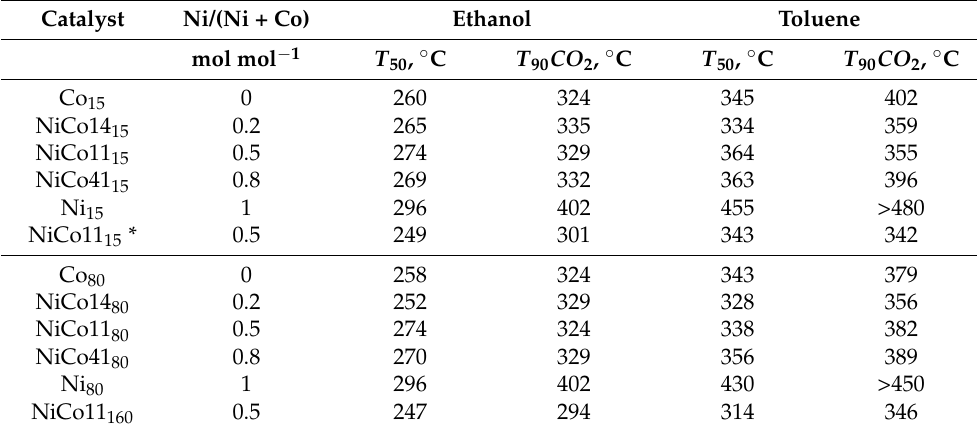
Table 6. T 50 and T 90 CO 2 temperatures in the oxidation of ethanol and toluene. Reaction conditions: ca. 3.8 g of sputtered catalysts; 760 ppm of ethanol or 780 ppm of toluene; GHSV 21 L g cat − l h − l ; temperature ramp: 2 ◦ C min − l